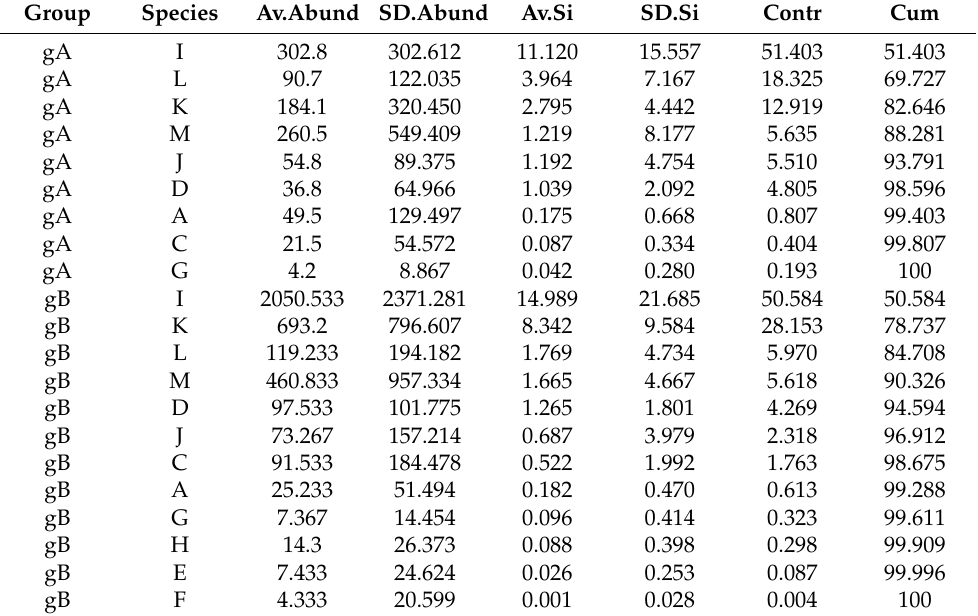
Table A4. SIMPER table obtained using the N90_resampling function from the $SIMPER_table object. Av.Abund and SD.Abund are the average and standard deviation values of the abundance, respec- tively; Av.Si and SD.Si are the mean and standard deviation of the contribution of each species to the within-group similarity; Contr is the percentage contribution to within-group similarity; and Cum is the cumulative percentage